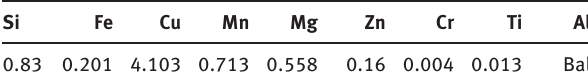
Table 1: Chemical composition (wt.%) of parent metal.